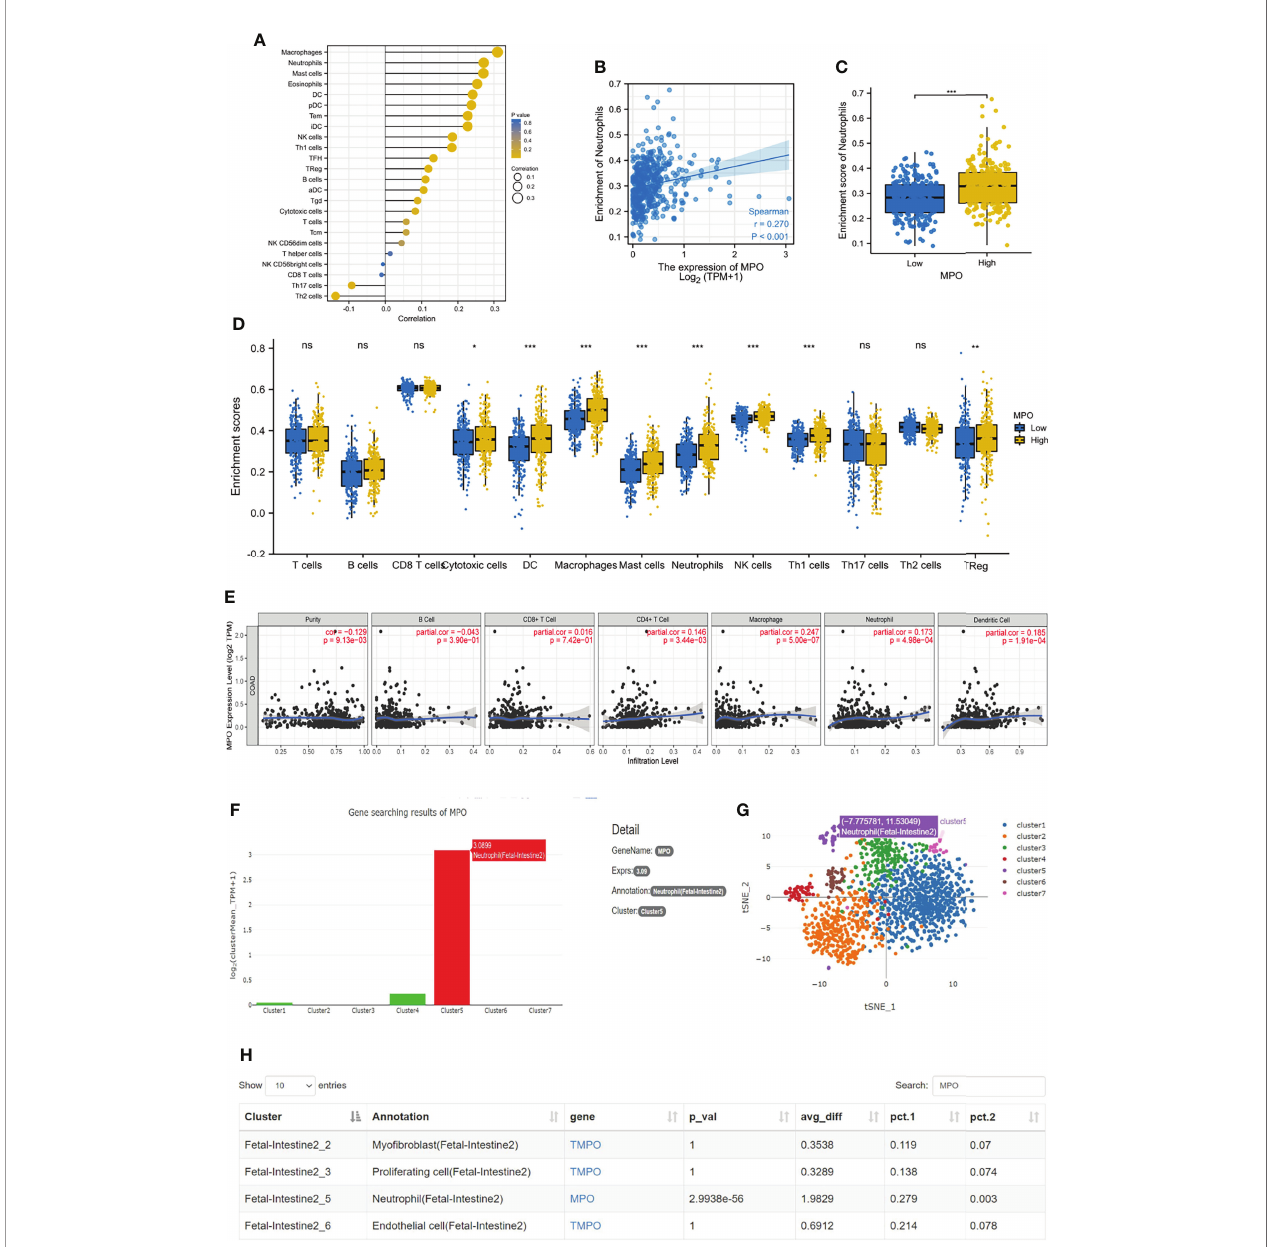
FIGURE 4 | MPO was signi fi cantly correlated with the in fi ltration level of neutrophils in CRC. (A) MPO expression has a signi fi cant correlation with many immune cells in fi ltration. (B, C) The correlation between MPO and neutrophils by the Wilcoxon signed-rank and Spearman correlation tests. (D) We analyzed the correlation between MPO expression and T cells, B cells, CD8+ T cells, cytotoxic cells, DC, macrophages, mast cells, neutrophils, NK cells, Th1 cells, Th17 cells, Th2 cells, and Tregs using ssGSEA. (E) The relationship between different immune cells and MPO was analyzed in TIMER 2.0, including B cells, CD8+ T cells, CD4+ T cells, macrophages, neutrophils, and DCs. (F – H) The relationship between MPO and neutrophils in a single-cell RNA sequencing database. The difference was considered signi fi cant at * P < 0.05, ** P < 0.01, or *** P < 0.001. ns, no signi fi